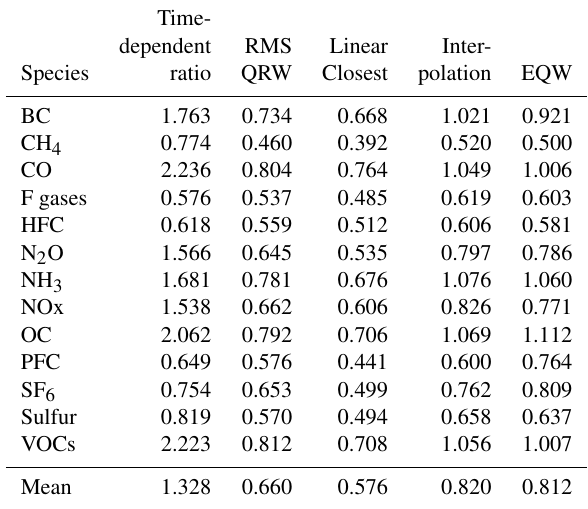
Table 4. Root mean squared error in reconstructing known data us- ing different crunchers, with CO 2 as the lead variable, normalised by the standard deviation at that